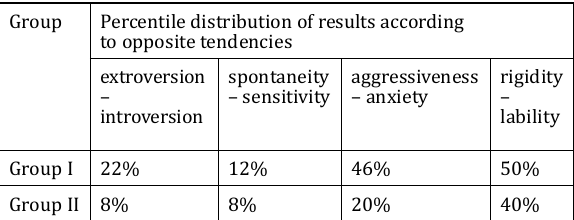
Table 2. Indicators of significant discrepancy in